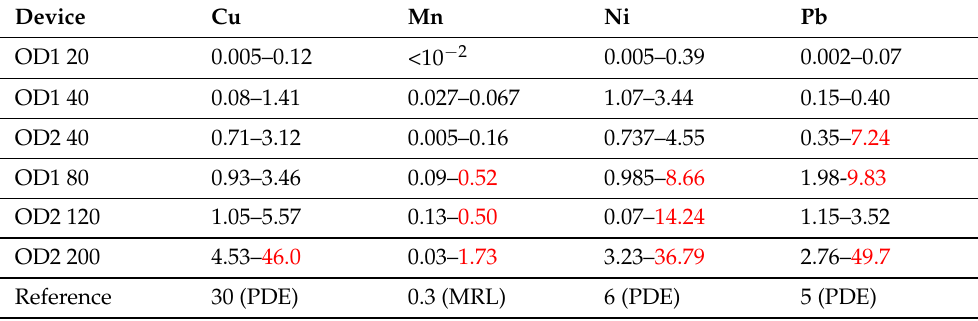
Table 6. Comparison of daily exposure of those metals from sub-ohm devices tested by the 2019 article Zhao et al. [11] whose daily exposure (in µ g) surpass toxicological reference values (displayed in red). The meaning of PDE and REL is explained in Table 2 and in the text of this section. Daily exposures for the remaining metals are below available toxicological reference, including zinc and iron whose contents are large. We assumed 250 as the average number of daily puffs for typical vapers to evaluate daily exposure to potential users.